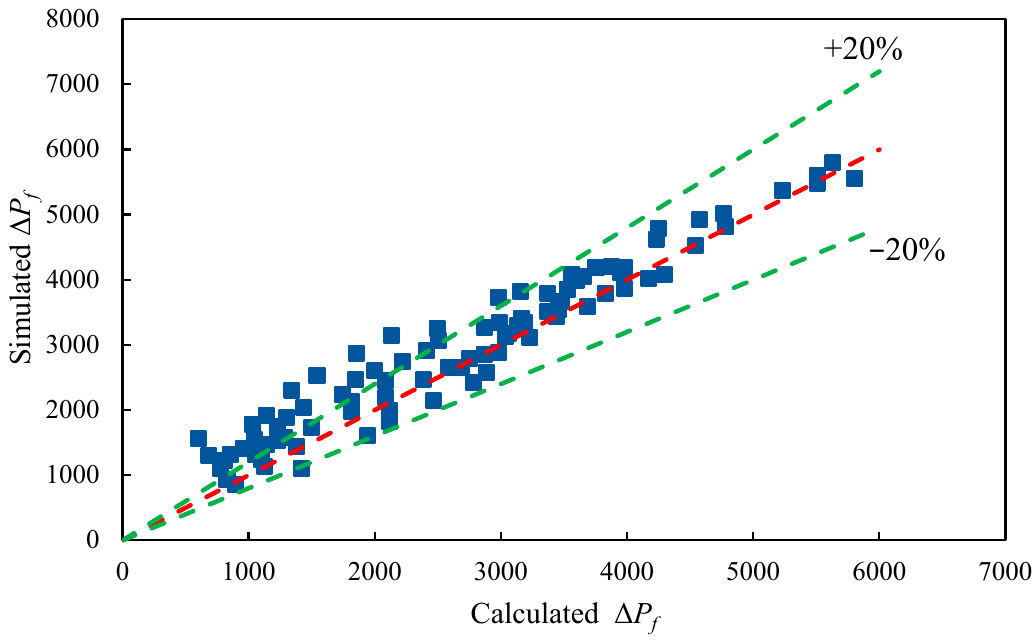
Figure 10. Frictional pressure gradient with inlet velocity at different gas void fractions.